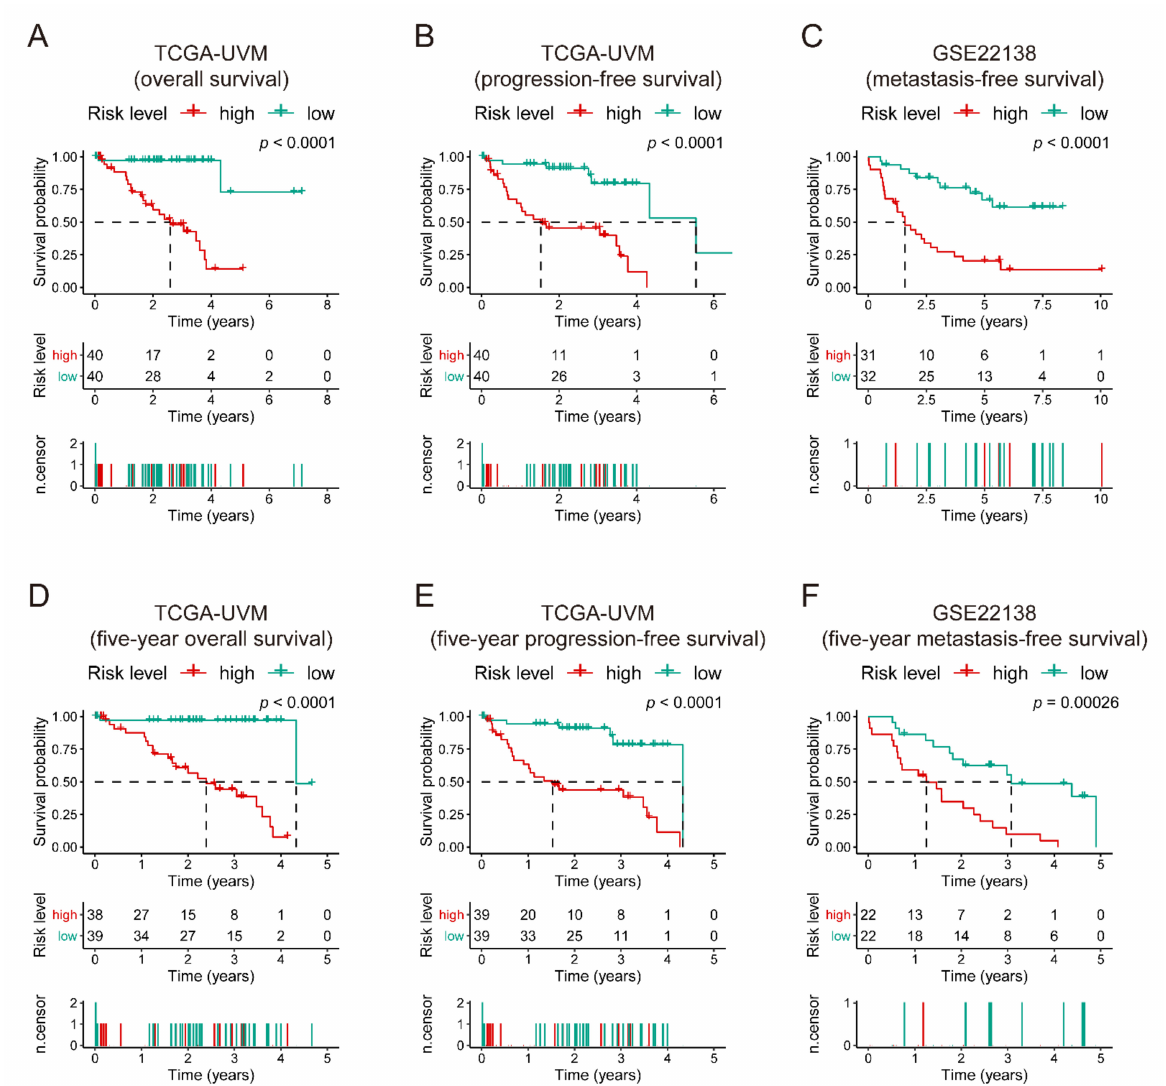
Figure 4. Kaplan–Meier curves of the seven-gene signature risk score in all cohorts. The middle part of each graph ( A – F ) indicates the number of patients at risk. The differences between the high- and low-risk groups were measured by log-rank ( p -value <